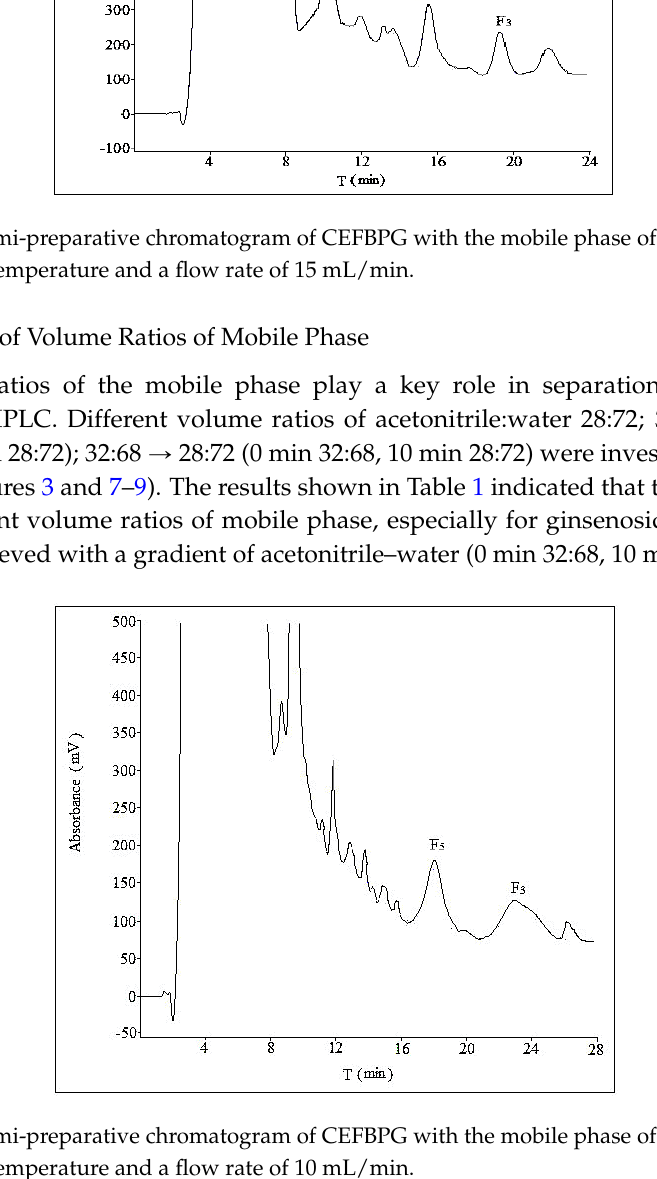
Figure 6. The semi-preparative chromatogram of CEFBPG with the mobile phase of acetonitrile:water (28:72) at room temperature and a flow rate of 15 mL/min.